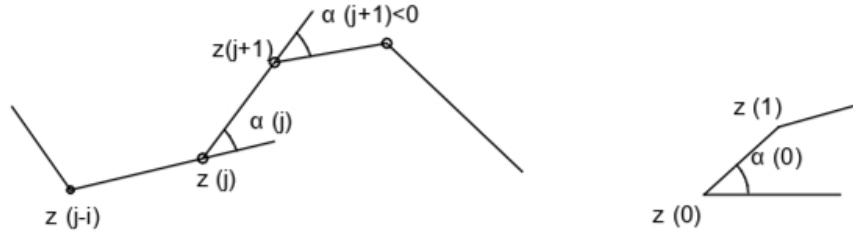
Figure 3. Angles in the complex-valued exponential function of the total curvature (redrawn)